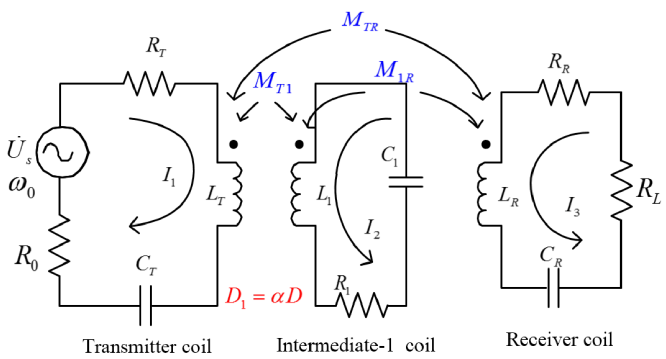
Figure 2. The equivalent circuit model of the MCR-WPT system with a single-intermediate